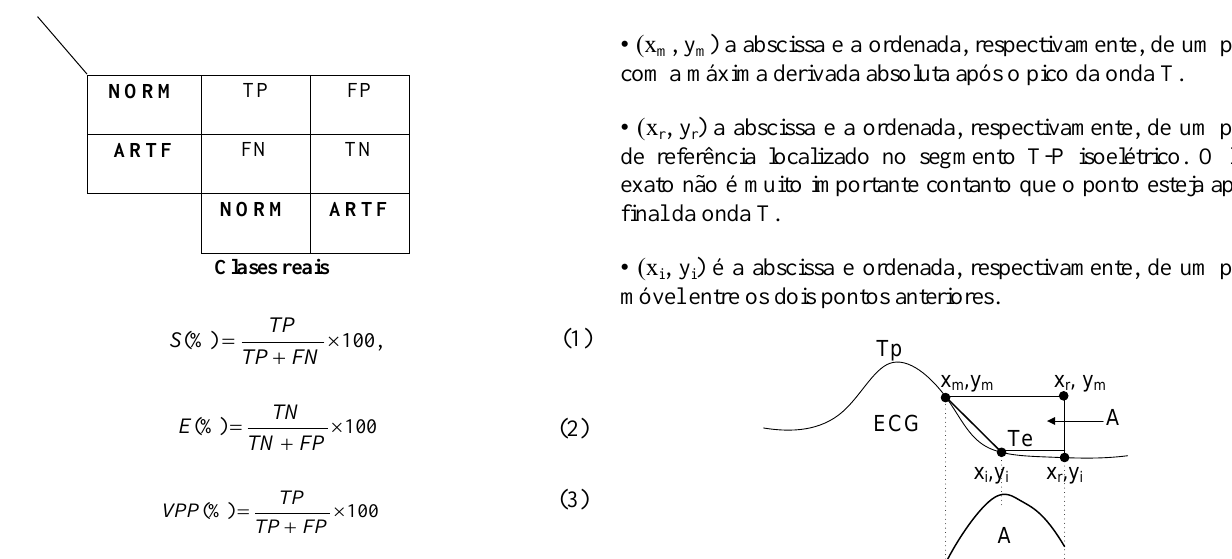
Figura 3. Matriz de confusão para cada classificador. VP: verdadeiros positivos, VN: verdadeiros negativos, FP: Falsos positivos, FN: Falsos negativos, S: Sensibilidade, E: Especificidade, VPP: Valor preditivo positivo.